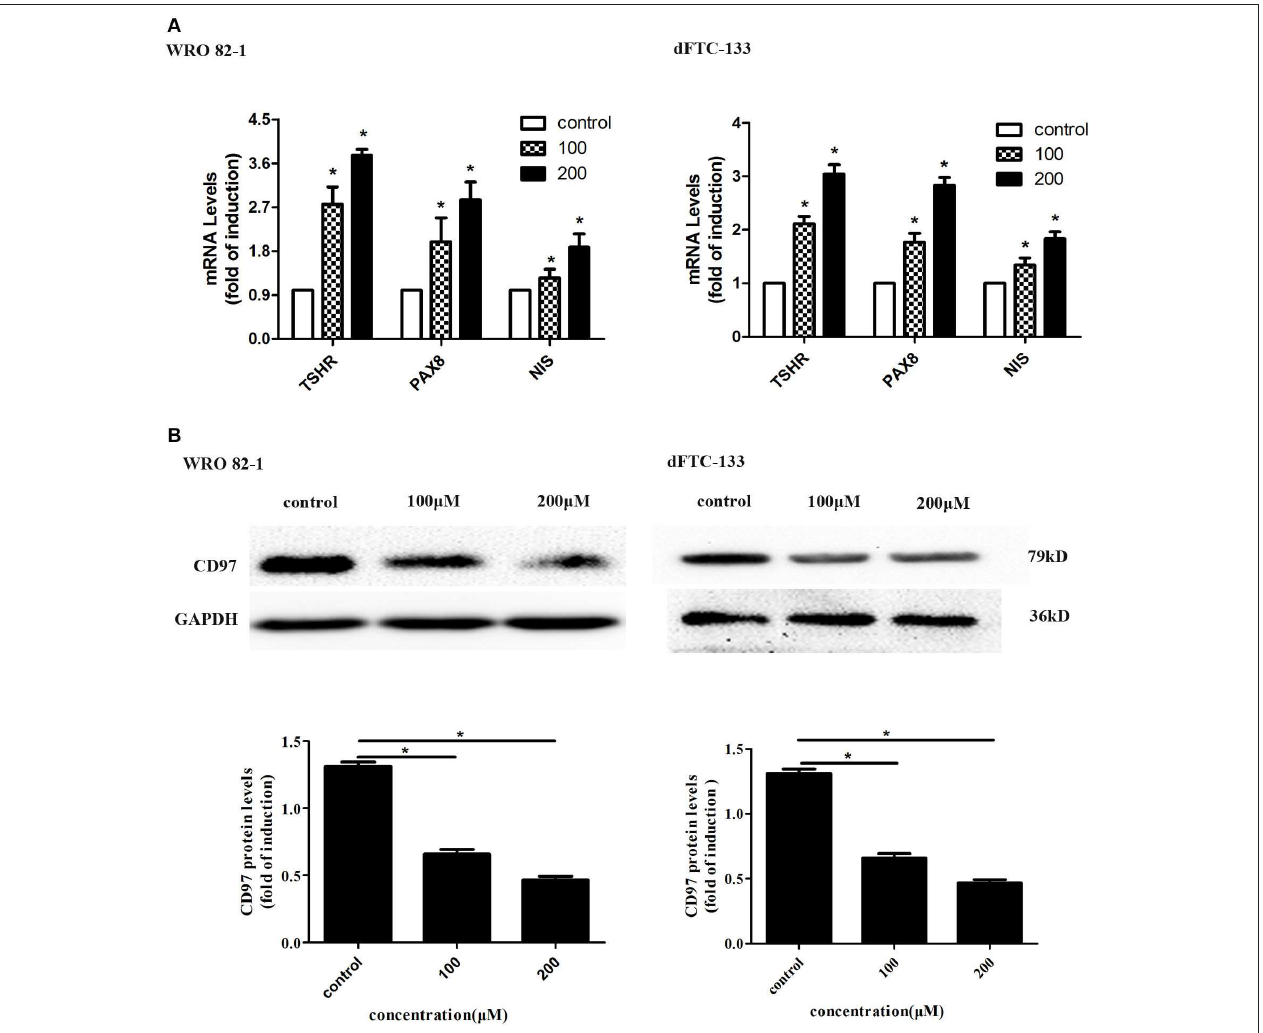
FIGURE 2 | Nevirapine promoted cell differentiation in dedifferentiated thyroid cancer WRO 82-1 and dFTC-133 cells. (A) The mRNA levels of thyroid differentiation specific genes (TSHR and NIS) and thyroid transcription factor PAX8 in WRO 82-1 and dFTC-133 cells treated by 200 µ M nevirapine for 72h were detected by RT-PCR. (B) The expression of CD97 protein in both cells with 100 and 200 µ M nevirapine for 72h was determined by western blot analysis. GAPDH was used as the loading control. The intensity of CD97 protein bands was quantified. Data are shown as the mean ± SD of three experiments. * P < 0.05 vs.